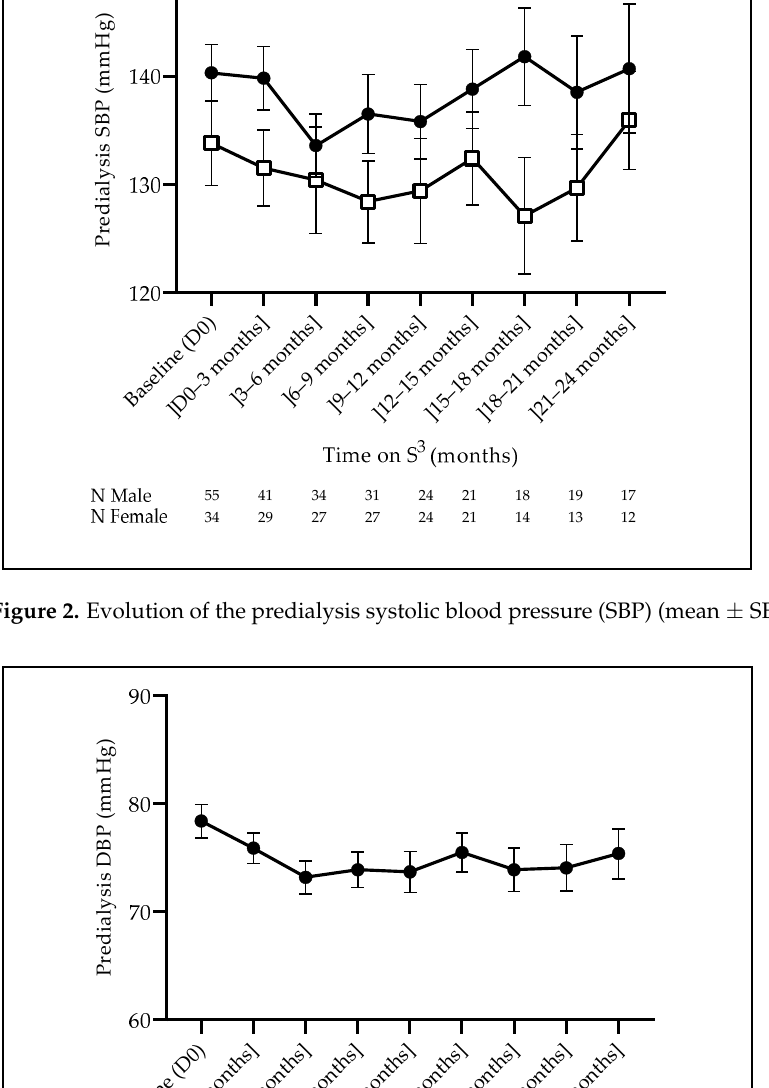
Figure 4. Evolution of plasma phosphate concentrations (median ± IQR). B a s e li n e ( D 0 ) ] D 0–3 m o n t h s ] ] 3–6 m o n t h s ] ] 6–9 m o n t h s ] ] 9–12 m o n t h s ] ] 12–15 m o n t h s ] ] 15–18 m o n t h s ] ] 18–21 m o n t h s ] ] 21–24 m o n t h s ] P h o s p h a t e ( mm o l / L )